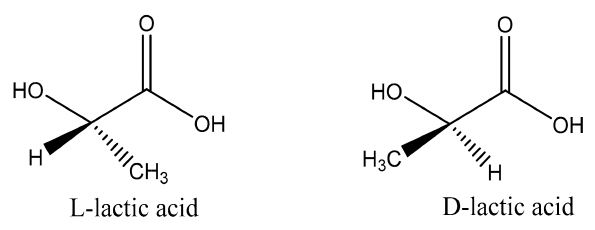
Figure 1. Enantiomers of lactic